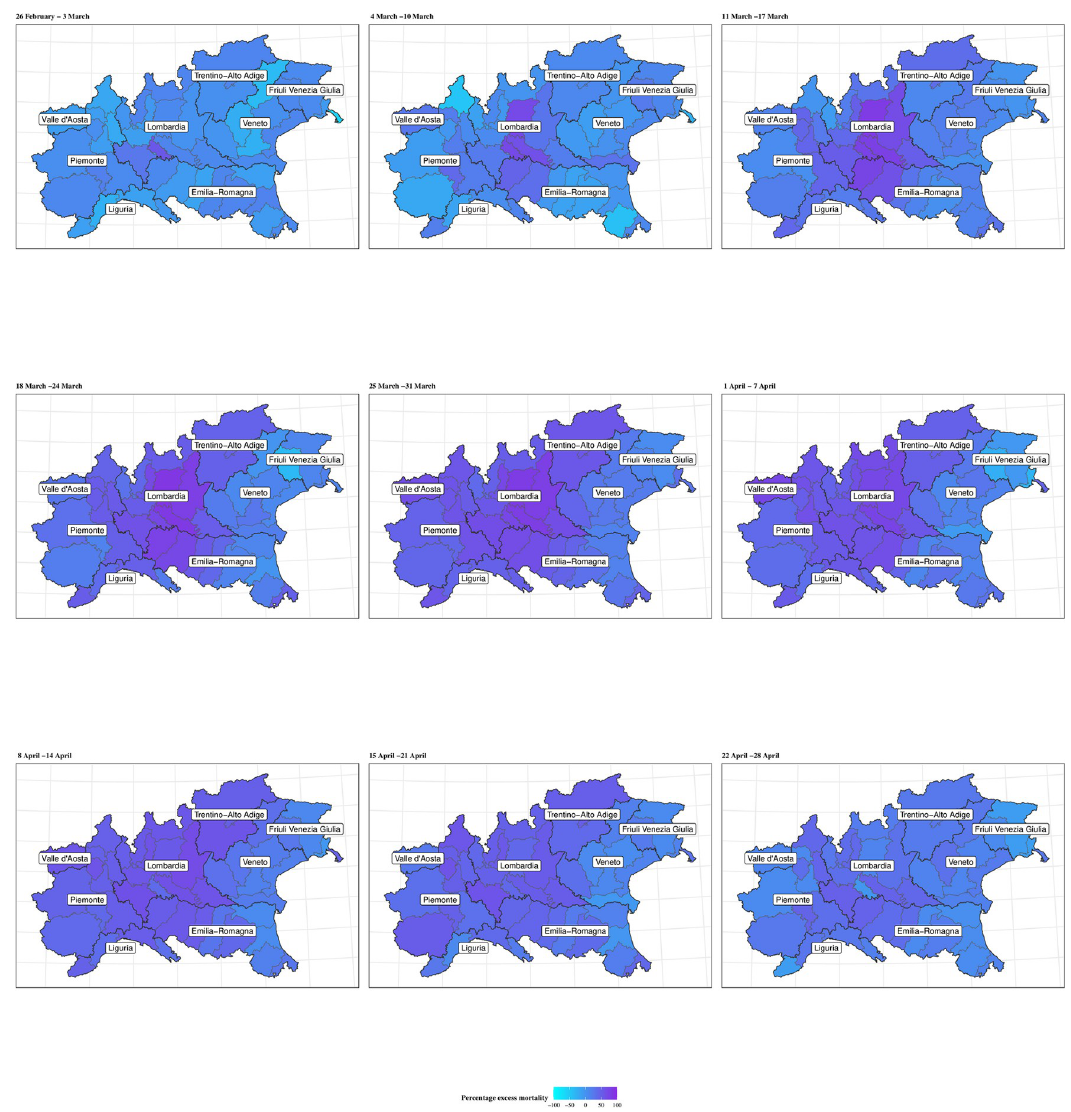
Fig 4. Percent excess mortality. Map of the percent excess mortality for the provinces in the areas of North-West, Lombardia and North-East of Italy, weekly posterior predictive mean in 2020 for females. Period: 25 February–28 April.